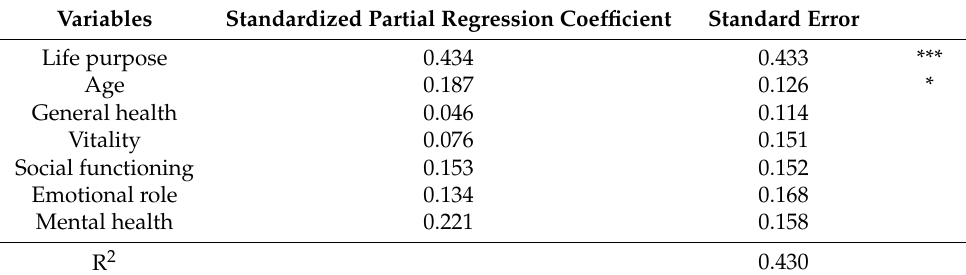
Table 4. Results of Multiple Regression Analysis on